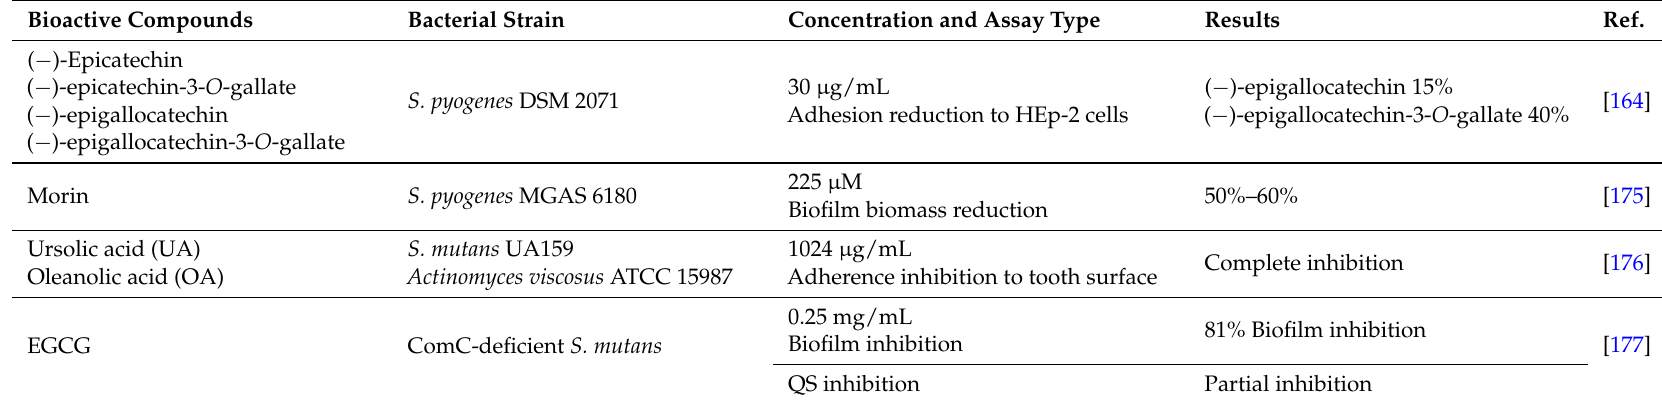
Table 5. Inhibitory effects of pure phytochemicals against adhesion, biofilm formation, quorum sensing and